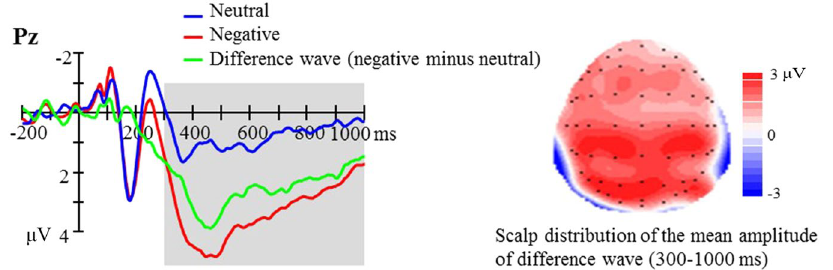
Figure 1. Left: ERPs time locked to the onset of neutral (blue line) and negative (red line) pictures as well as their difference wave (green line). Right: The scalp topography of LPP difference wave in the time window of 300–1000 ms.